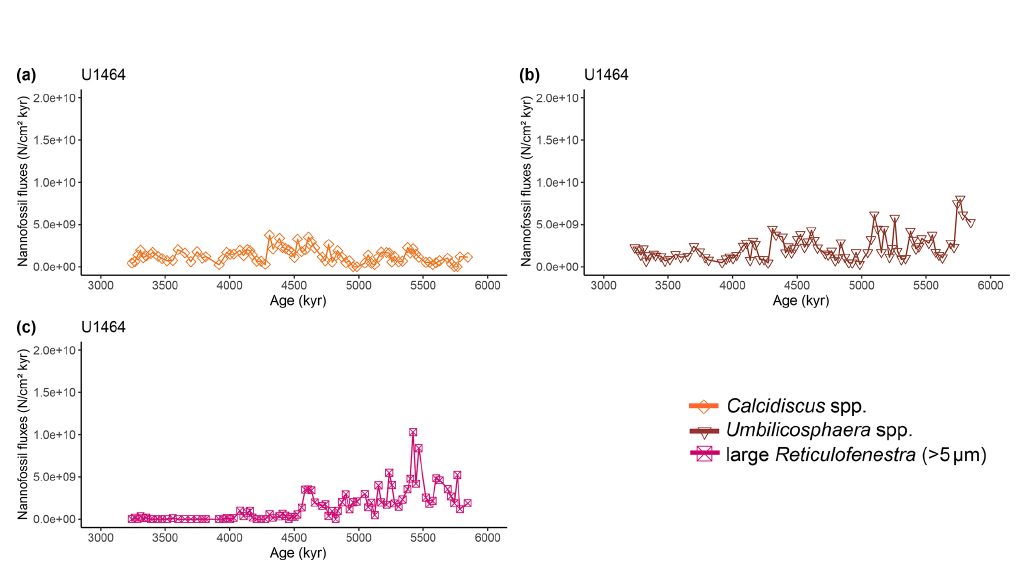
https://doi.org/10.5194/cp-19-765-2023 Clim. Past, 19, 765–786,